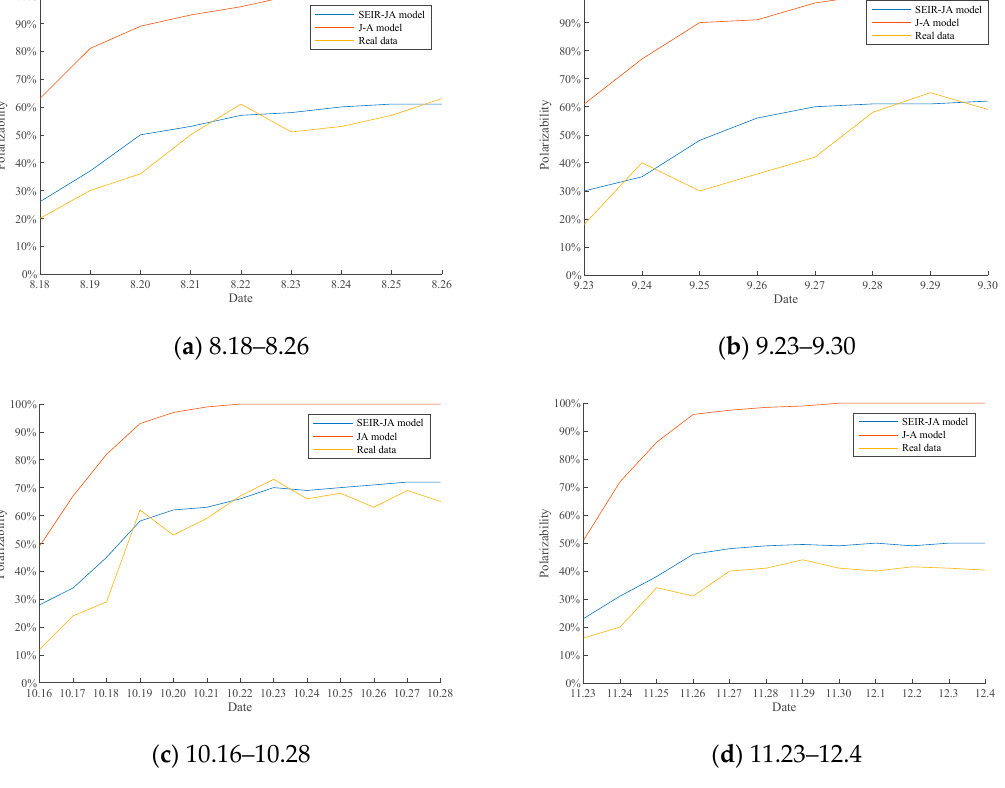
Figure 17. Comparison of polarizability.